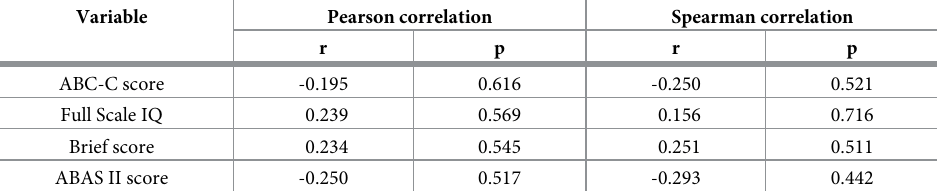
Table 3. Association between rate of protein synthesis measurements and cognitive evaluations.